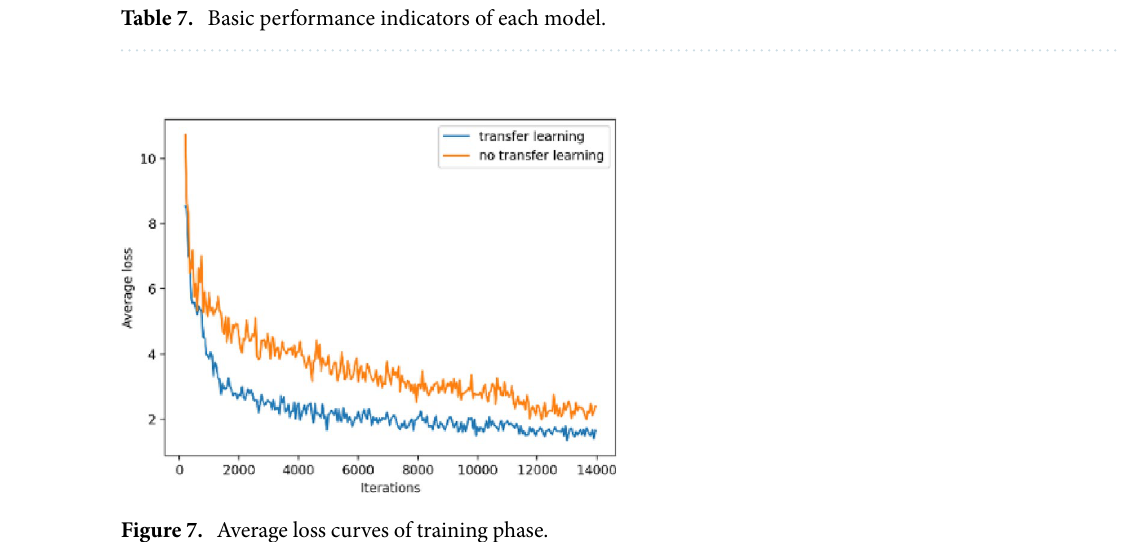
Figure 7. Average loss curves of training phase.